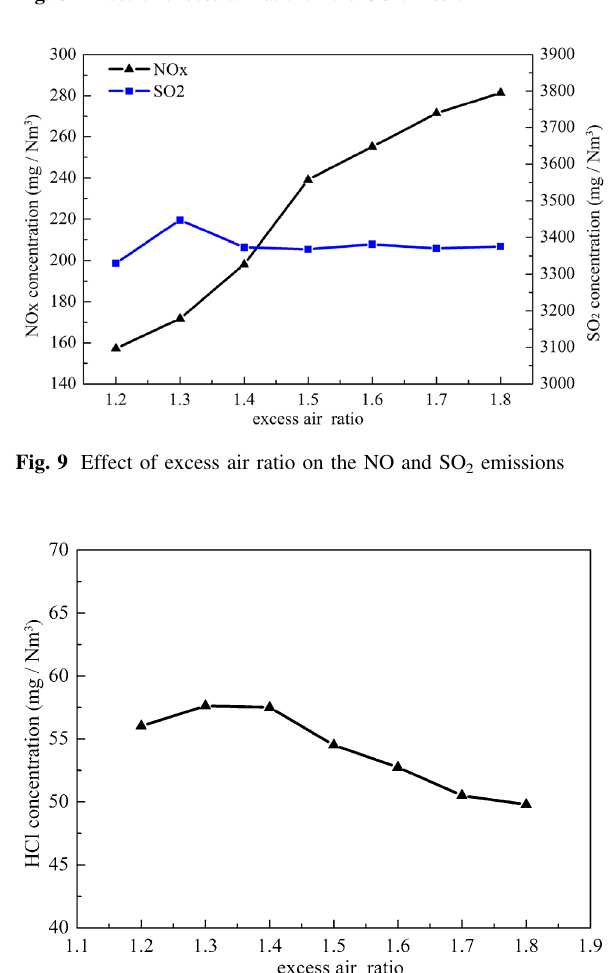
Fig. 8 Effect of excess air ratio on the CO emission